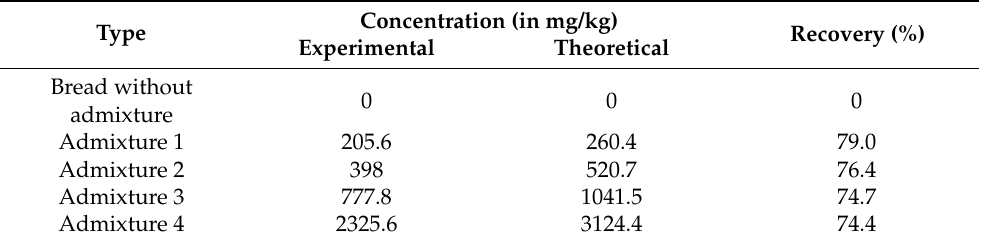
Table 2. The theoretical and experimental concentration expressed in mg/kg as well as the recovery values (%) of propionic acid in bread samples.